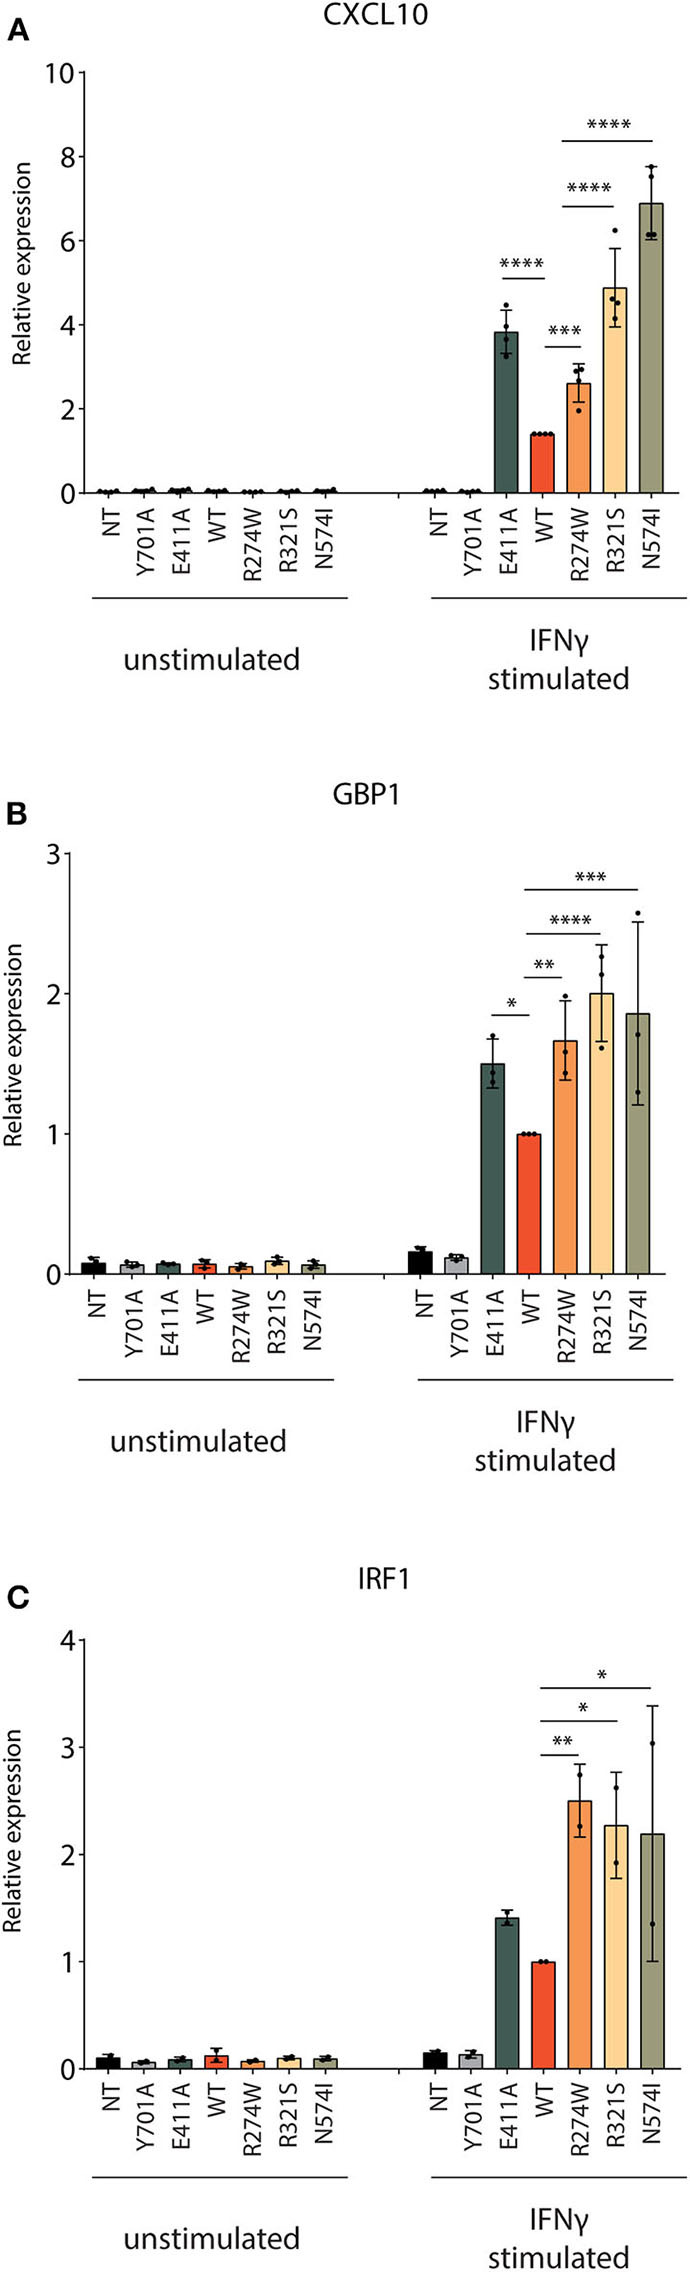
Quantification of ISGs expression level. The mRNA expression level of three ISGs (A) CXCL10, (B) GBP1 and (C) IRF1 was measured before and after 4 h stimulation with IFNγ (1 U/μl). Expression levels were normalized for housekeeping PSIP1 mRNA expression and plotted as fold increase compared to IFNγ stimulated STAT1 WT condition for each experiment. The experiment was independently repeated 2–4 times for each gene and pooled data are presented. Data are represented in bar graphs as mean ± standard deviation. Statistical analysis: One-way ANOVA with Tukey's post-hoc test. *P < 0.05; **P < 0.01; ***P < 0.001; ****P < 0.0001.